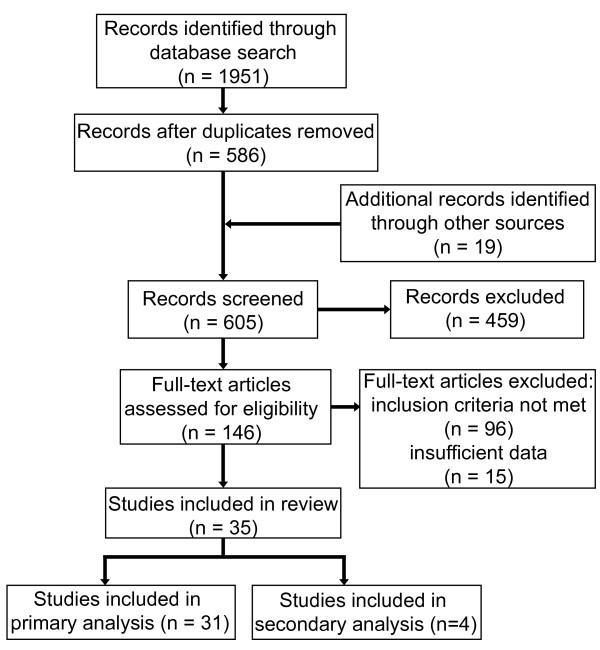
Flow chart of search results and study selection.